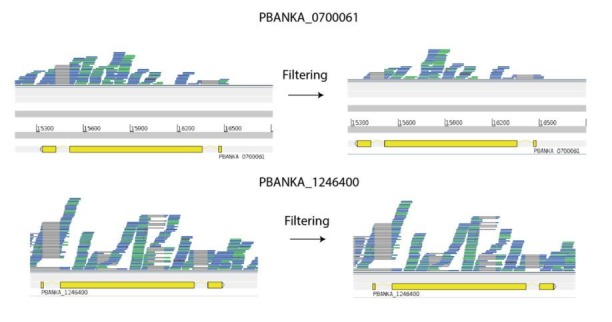
Many reads map uniquely to similar pir genes.Despite being very similar in identity (88% at the nucleotide level), most reads deriving from these transcripts map uniquely. It is notable here that there appears to be variable splicing of coding regions of PBANKA_1246400. This is a novelty which we are currently following up. Genes are shown in yellow. Reads (blue and green lines) are shown mapped to the genes, Green reads represent collapsed duplicates for the purpose of easier visualisation. Grey lines are where reads are split e.g. across introns. Red marks represent mismatches between reads and the reference.